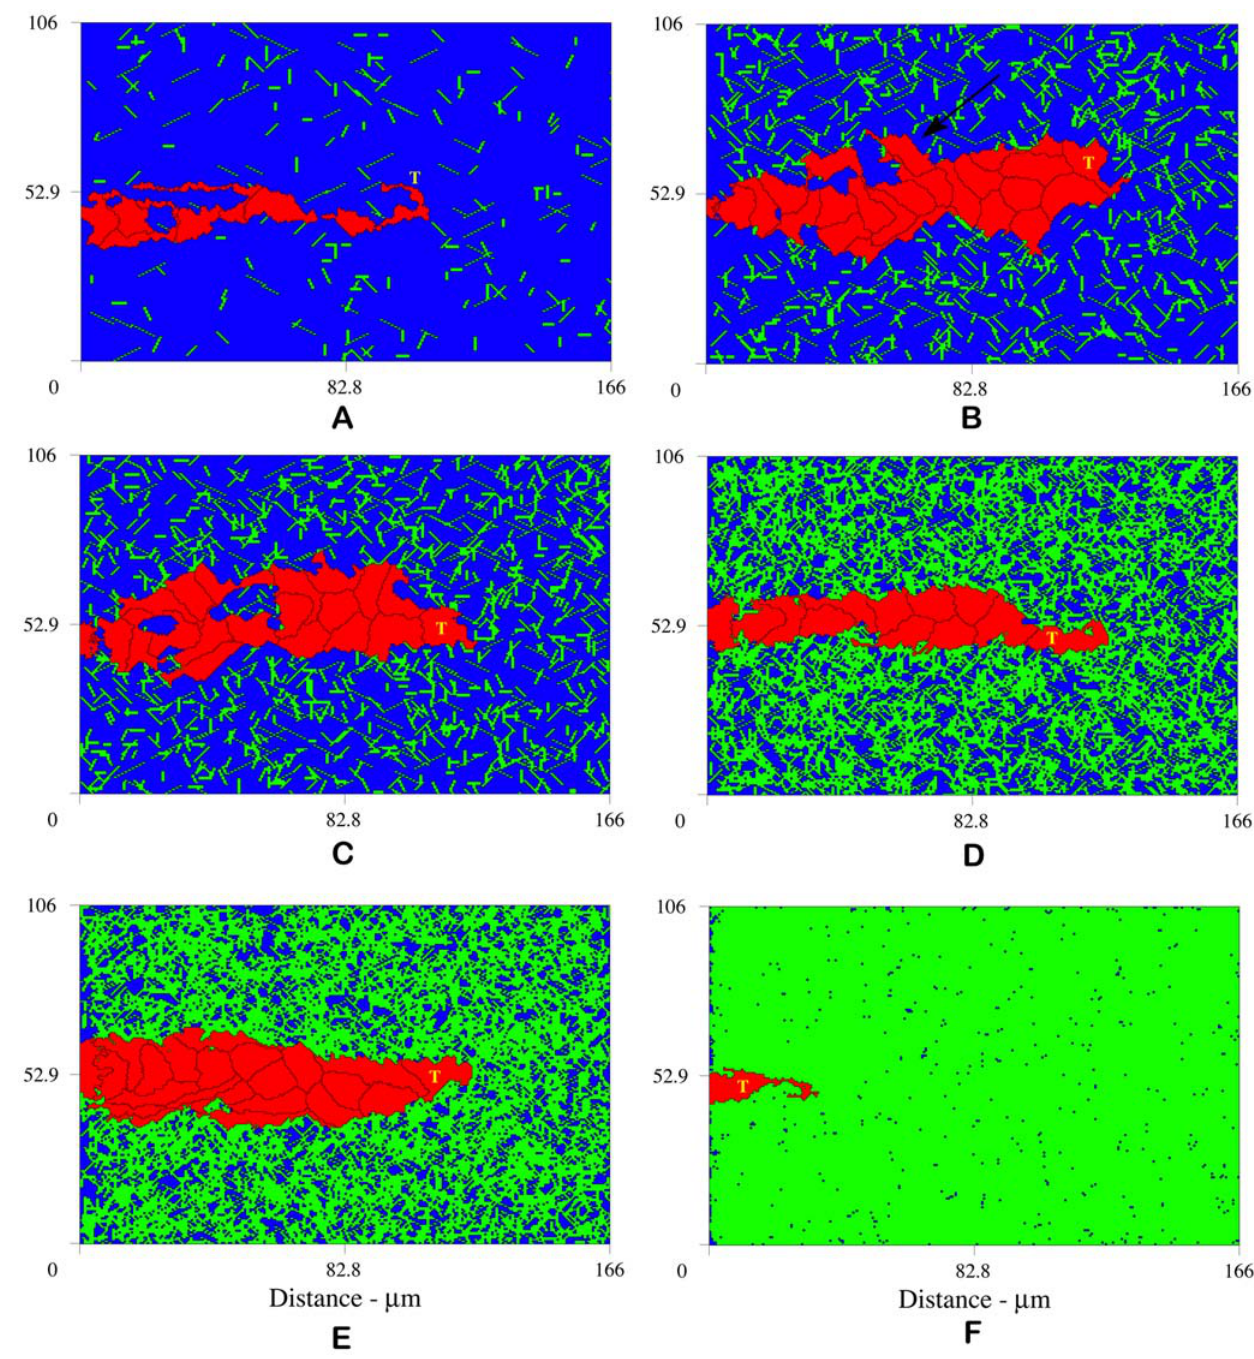
Figure 3. Plots showing the effect of the mechanical properties and heterogeneity of the ECM on sprout morphology and viability. From top left to bottom right: (A) r ~ 0 : 05 , interruption of normal angiogenesis and loss of sprout viability; (B) r ~ 0 : 2 , high matrix heterogeneity induces branching (arrow points to new branch); (C) r ~ 0 : 25 , anastomosis; (D) r ~ 0 : 6 , more homogeneous matrix fiber network produces linear sprouts; (E) r ~ 0 : 7 , higher matrix homogeneity causes loss of strong guidance cues resulting in wider and slower sprout formation; and (F) r ~ 0 : 975 , complete inhibition of angiogenesis at high matrix density. Snapshots at 14 hours. are severely elongated, detach from each other, do not grow, or do not form a cohesive sprout body. For 0 : 15 ƒ r ƒ 0 : 25 , the fiber network is highly inhomogeneous, and we know that lower matrix densities transfer a larger amounts of r w 0 : 8 because sprouts show developmental defects, that is, cells strain to the cells. As a result we see an increase in cell spreading and